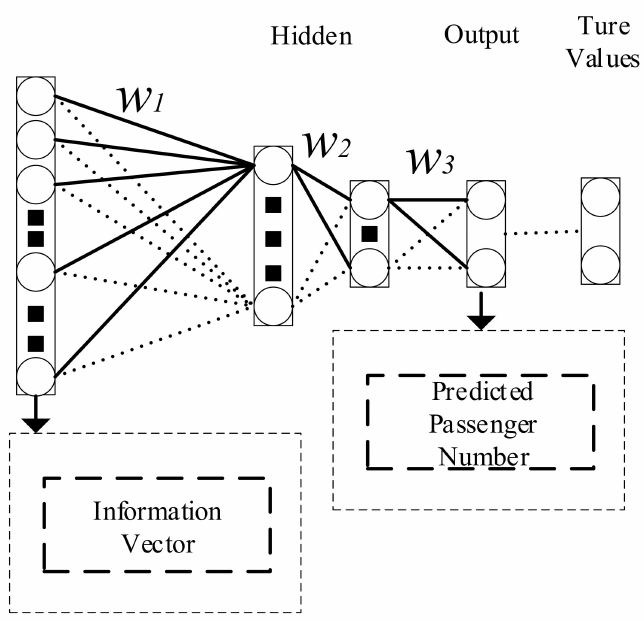
Figure 5. The process of the information